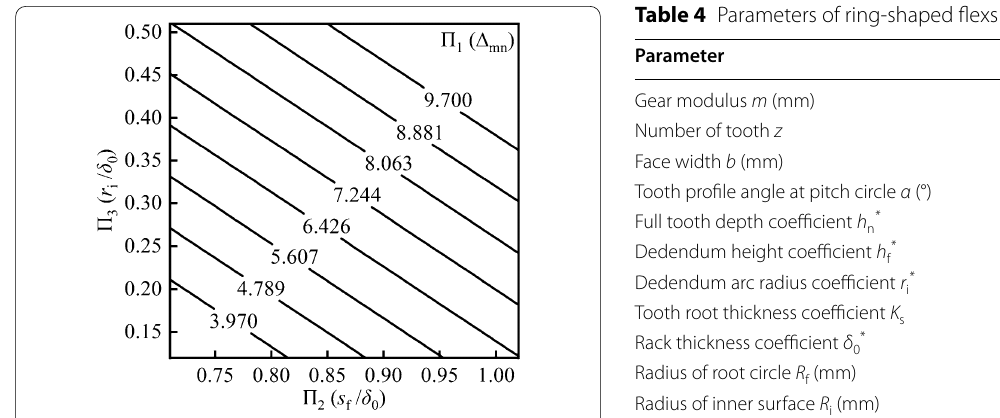
Figure 14 Contour map of the fitted results of equivalent neutral layer offset ratio Δ mn